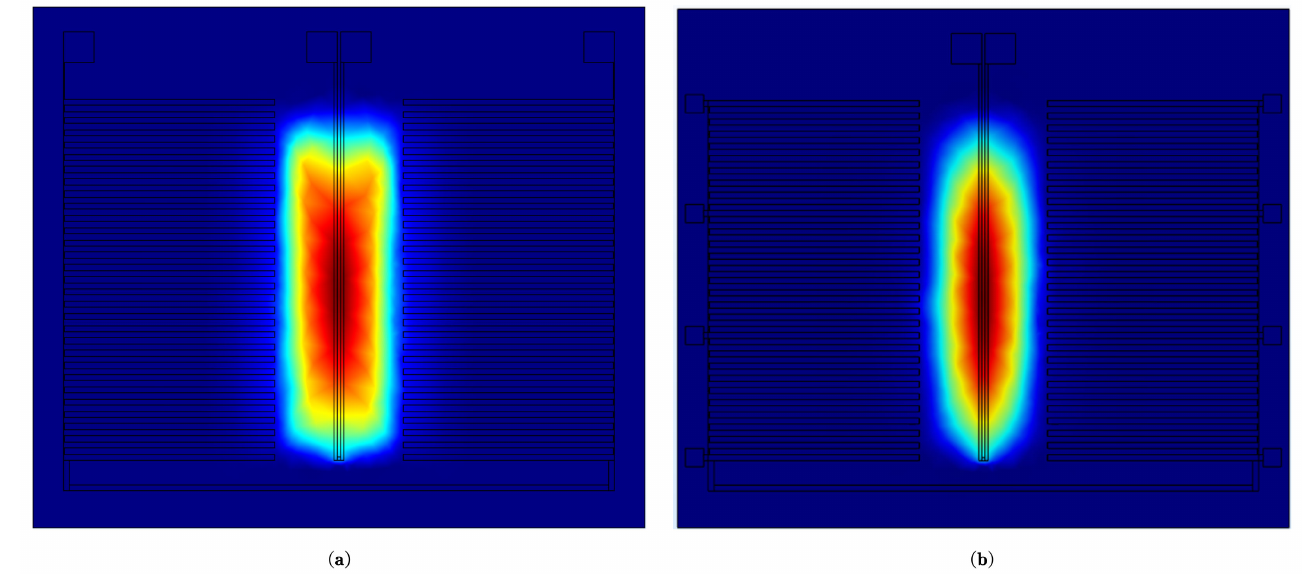
Figure 3. Temperature gradient on membrane by ( a ) physical stimulus and ( b ) electrical stimulus. Table 1. Temperature range on membrane by physical stimulus and electrical